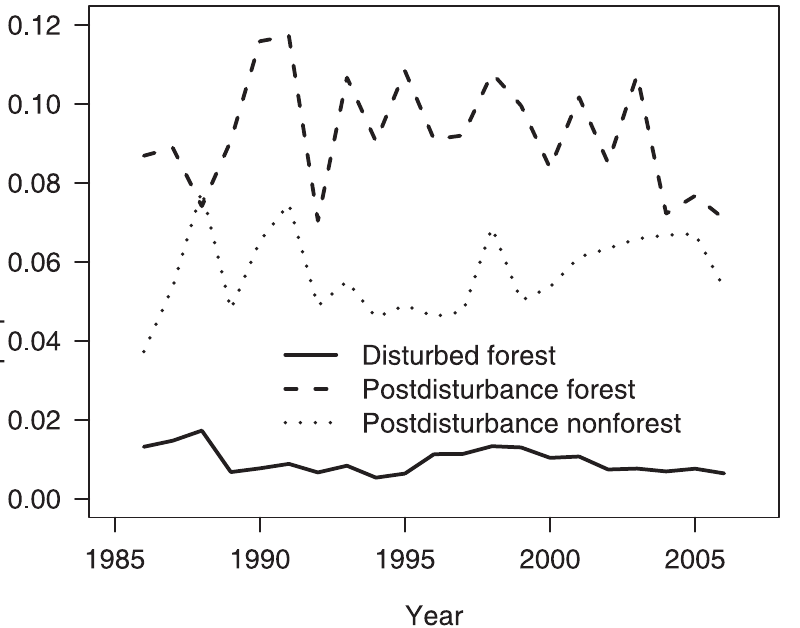
Figure 3. Median proportion of disturbed forest, post-disturbance forest (regenerating forest) and post-disturbance non-forest (forest loss) within a 1200-km 2 circular landscape surrounding Breeding Bird Survey routes located in forested ecoregions of the conterminous United States. See Fig. 1 for locations of Breeding Bird Survey routes.